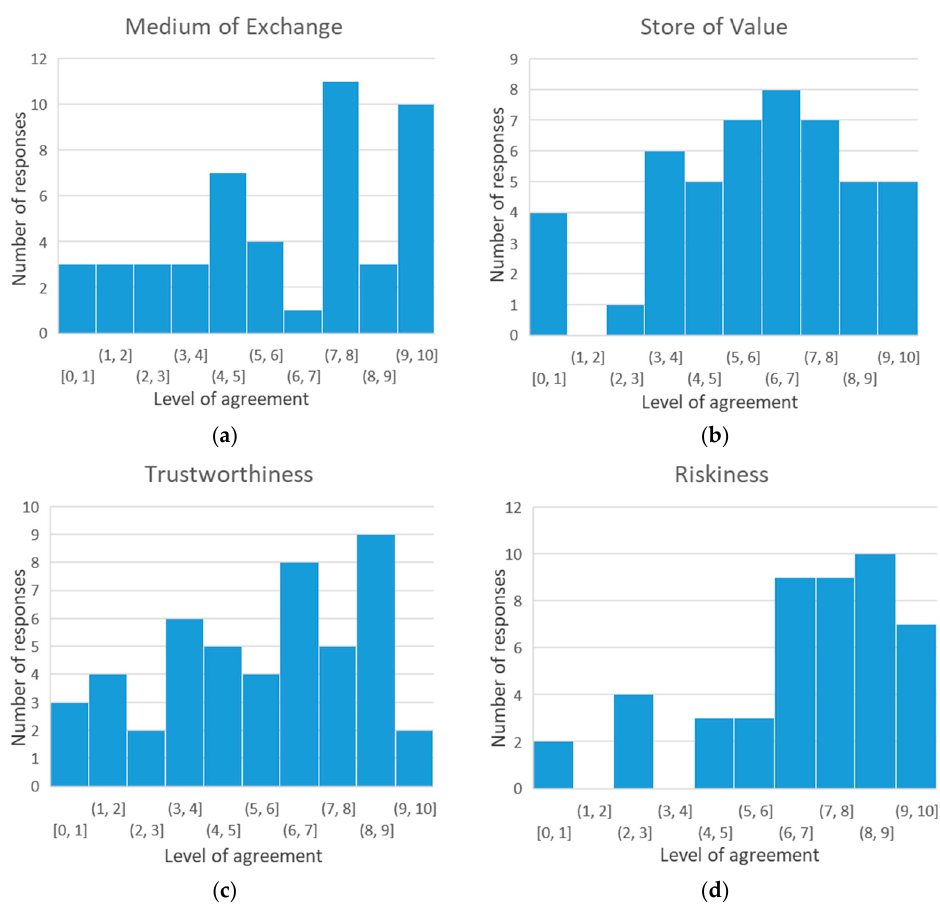
Figure 2. Histograms illustrating the evaluation of Bitcoin: ( a ) medium of exchange; ( b ) store of value; ( c ) trustworthiness; ( d ) riskiness ( n = 51). Table 2. Influencing factors (properties) on different